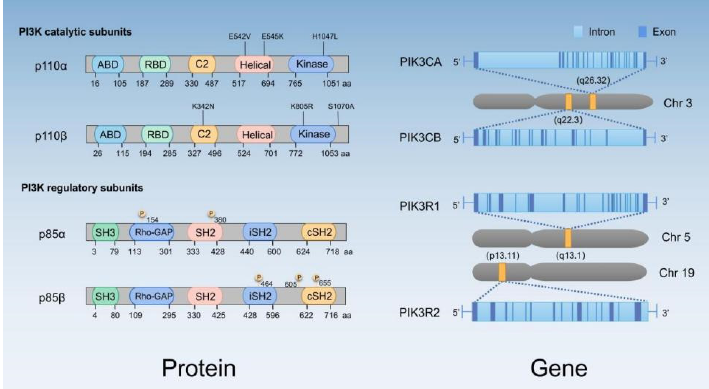
Figure 1. The genes and proteins of class I PI3K. The catalytic subunits p110 α /p110 β , the regulatory subunits p85 α /p85 β and the genes that encoded these subunits (PIK3CA, PIK3CB, PIK3R1 and PIK3R2) are shown. ABD, albumin binding domain; RBD, RAS-binding domain; C2, protein kinase C conserved region 2; Rho-GAP, Rho GTPase-activating protein; SH2, Src homology 2 domain; iSH2, inter-SH2; cSH2, C-terminal SH2.